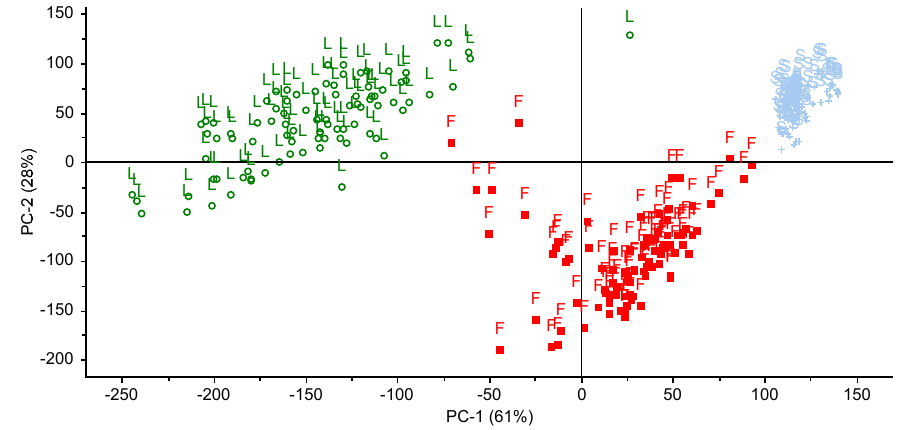
Figure 2. Principal component analysis scores plot of showing PC1 (principal component 1) vs. PC2 using spectra from 368 to 1048 nm. ▪ and F, fecal matter on leaf; + and S, soil on leaf; o and L, uncontaminated leaf.